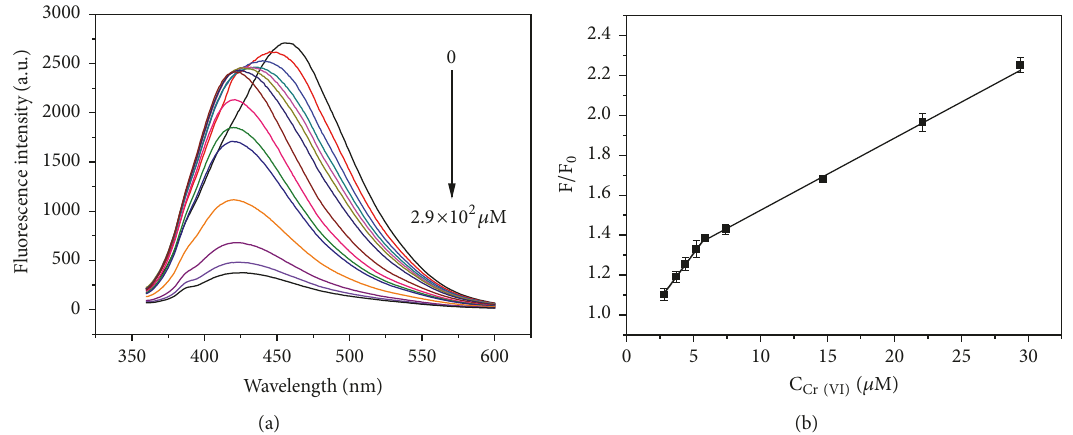
Figure 2: (a) Fluorescence spectra of F-hPEI-capped Au NPs with the addition of different concentrations of Cr (VI) ranging from 0 𝜇 M to 2.9 × 10 2 𝜇 M. (b) The corresponding calibration curve for this sensor over the range from 2.8 𝜇 M to 29 𝜇 M. The error bars represent the standard deviation of three